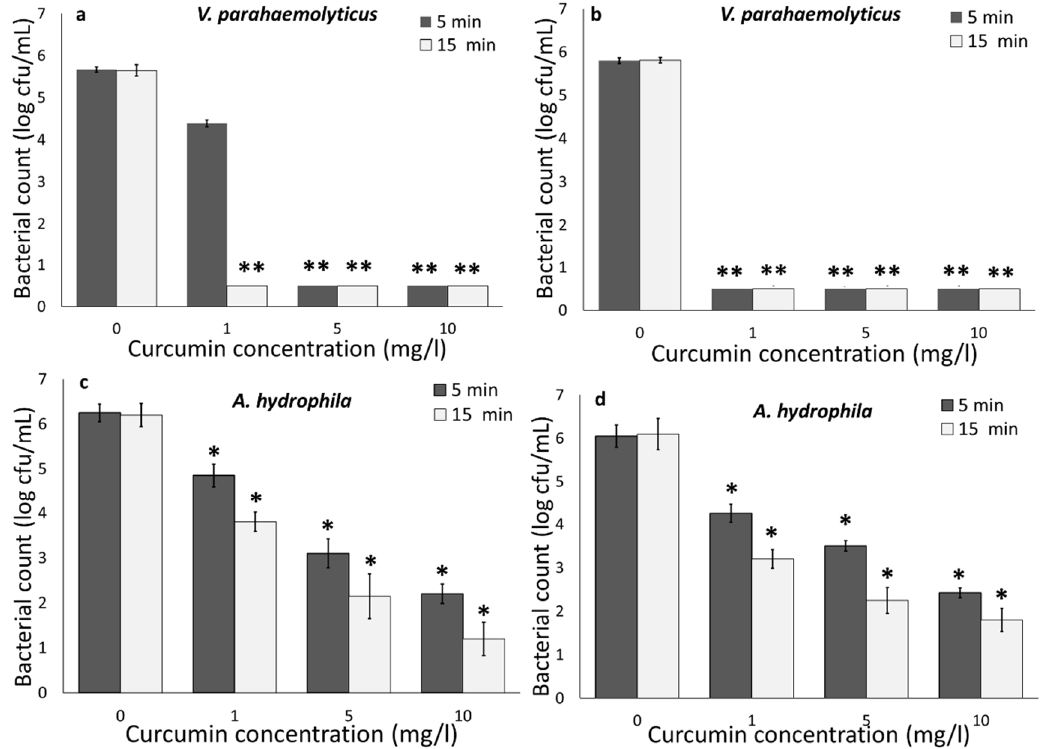
Figure 1. Effect of curcumin concentrations on the inactivation of V. parahaemolyticus at ( a ) 22 and ( b ) 4 °C, and A. hydrophila at ( c ) 22 and ( d ) 4 °C, using UV-A and curcumin. Statistical difference was determined based on p < 0.05 (*). Samples with two asterisks (**) were below the limit of detection (0.5 log cfu/mL).